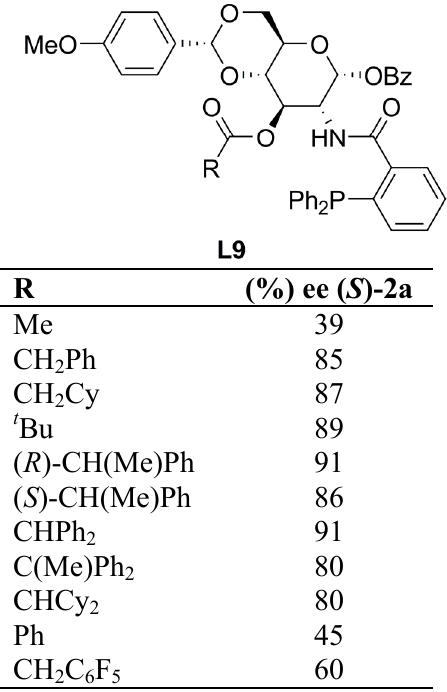
Table 2. Asymmetric allylic alkylation reaction with L9